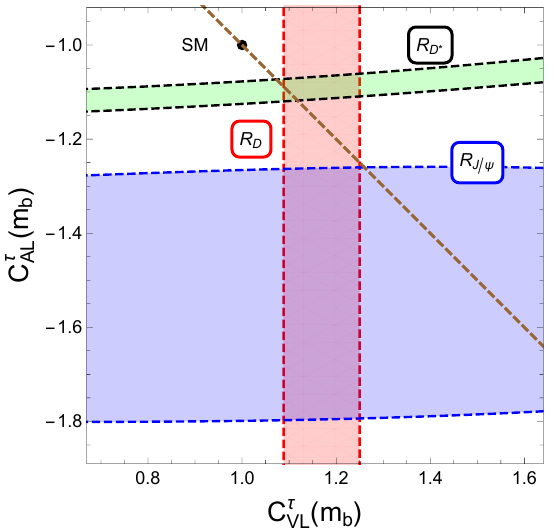
Figure 1 . The vertical red band corresponds to the values of C (cid:28) measurement of R D within 1 (cid:27) . Similarly, the green (blue) region corresponds to the values of C (cid:28) and C (cid:28) that satisfy the experimental measurement of R D (cid:3) ( R AL de(cid:12)nes at the m b scale. The oblique dashed line is the locus of the equation C (cid:28)